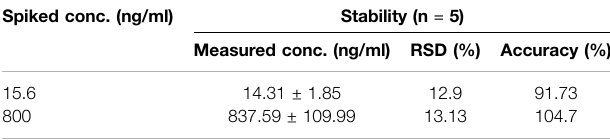
TABLE 2 | The long-term (15 days) stability of analytes. Spiked conc.